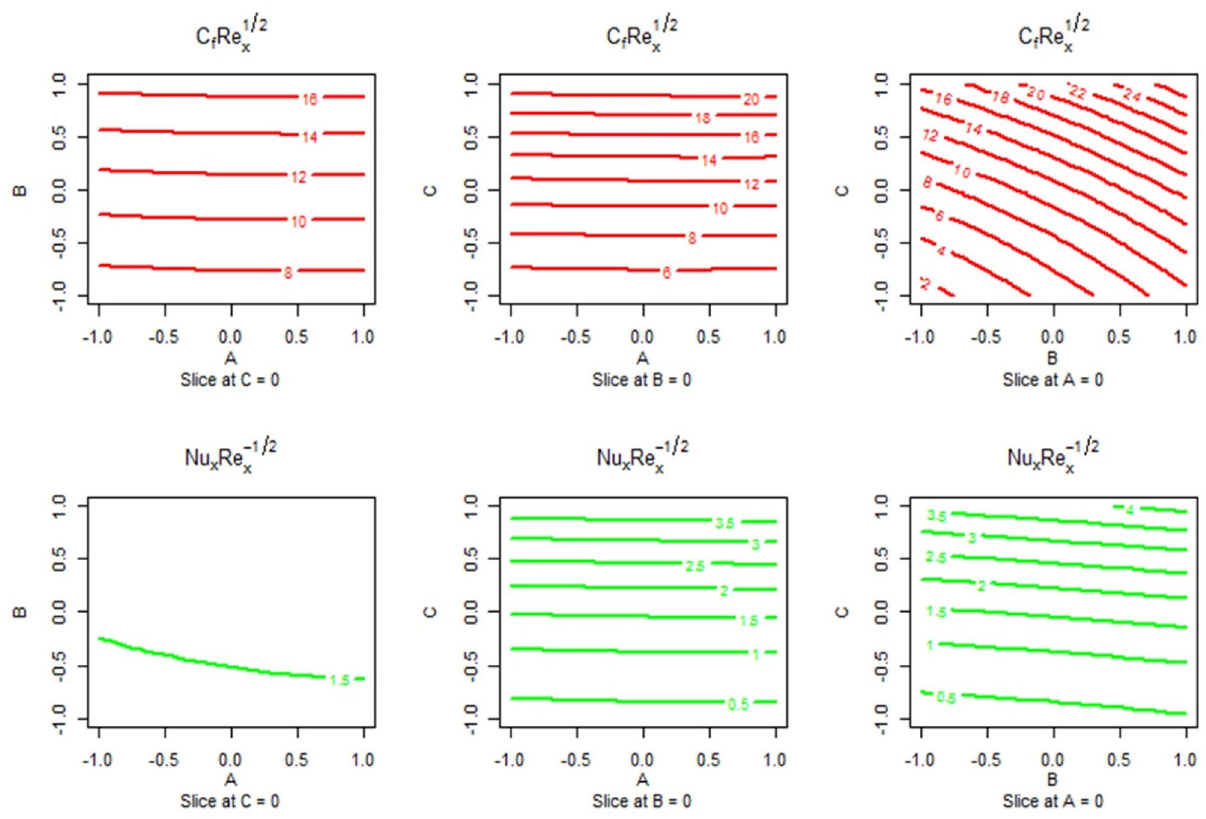
Figure 14. Predicted responses of C f √ Re x and Nu / √ Re x as a function of input parameters with different combinations of ( A & B ), ( A & C ), and ( B & C